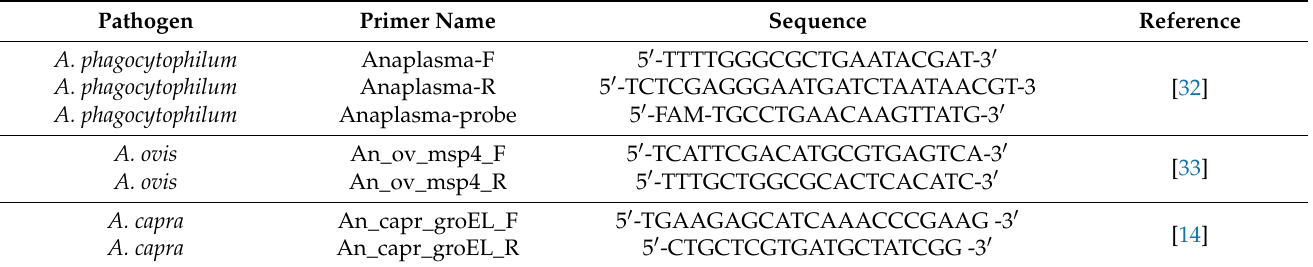
Table 1. Sequences of the primers and probes used to detect DNA from Anaplasma phagocytophilum , A. ovis and A. capra . DNA from A. phagocytophilum was detected with quantitative PCR, while DNA from A. ovis and A. capra was detected using conventional